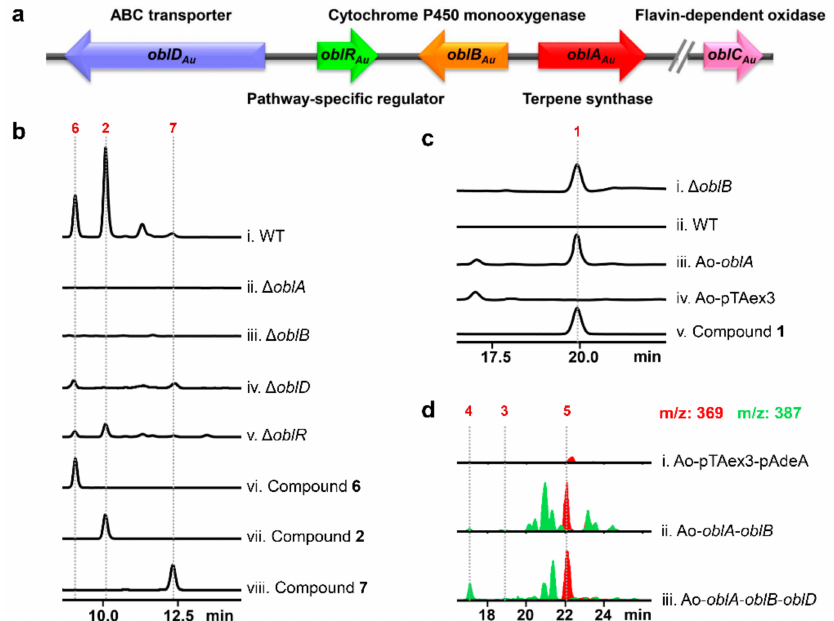
Figure 2. Functional confirmation of genes in ophiobolin biosynthesis gene cluster of Aspergillus ustus 094102 ( obl Au ). ( a ) Ophiobolin biosynthetic gene cluster in A. ustus 094102. ( b ) HPLC profiles of standards and culture extracts from wild-type (WT) strain and mutants at the wavelength of 234 nm. ( c ) HPLC analysis of WT strain, ∆ oblB, Ao-pTAex3 and Ao- oblA at the wavelength of 200 nm. ( d ) LC– ESI-HRMS analysis of culture extracts from Aspergillus oryzae transformants. Peaks of m/z 369 (red) and m/z 387 (green) were